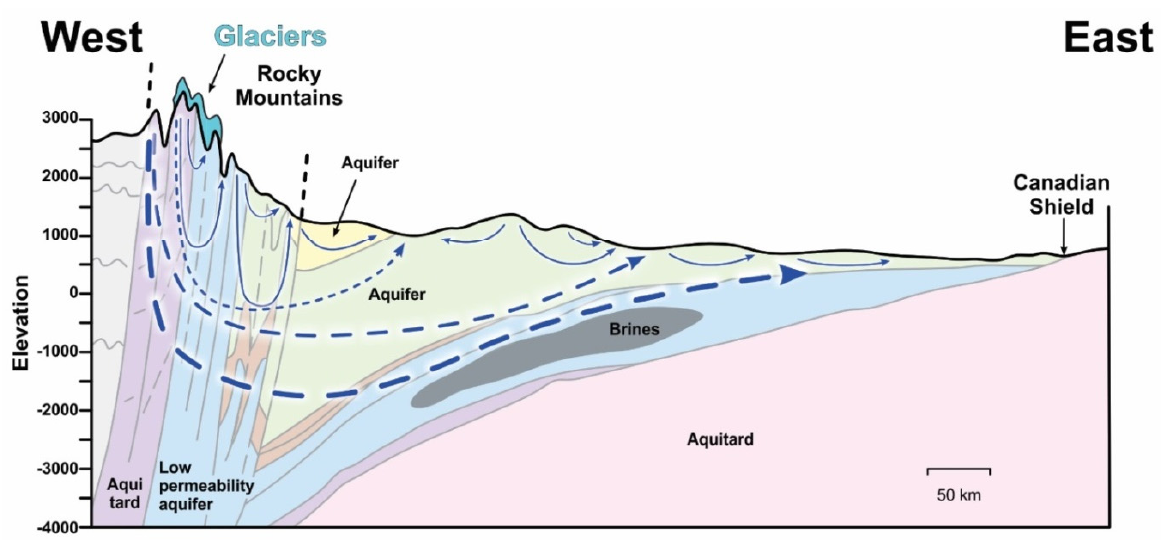
Figure 4. Two-dimensional conceptual hydrogeological model and groundwater flow lines (vertical exaggeration = 47).